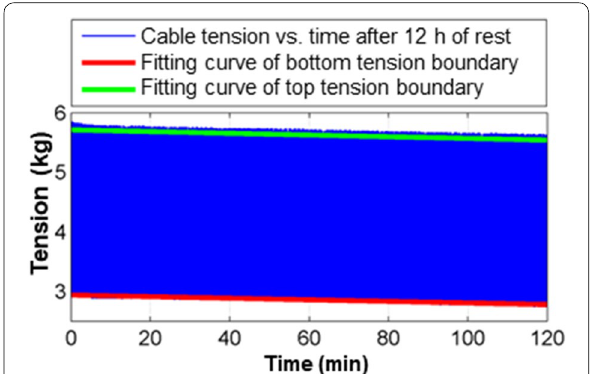
Figure 8 Cable tension relaxation vs. time after 12 h of rest and the fitting curves of the bottom and top tension boundaries Figure 9 Tension relaxation after first and second